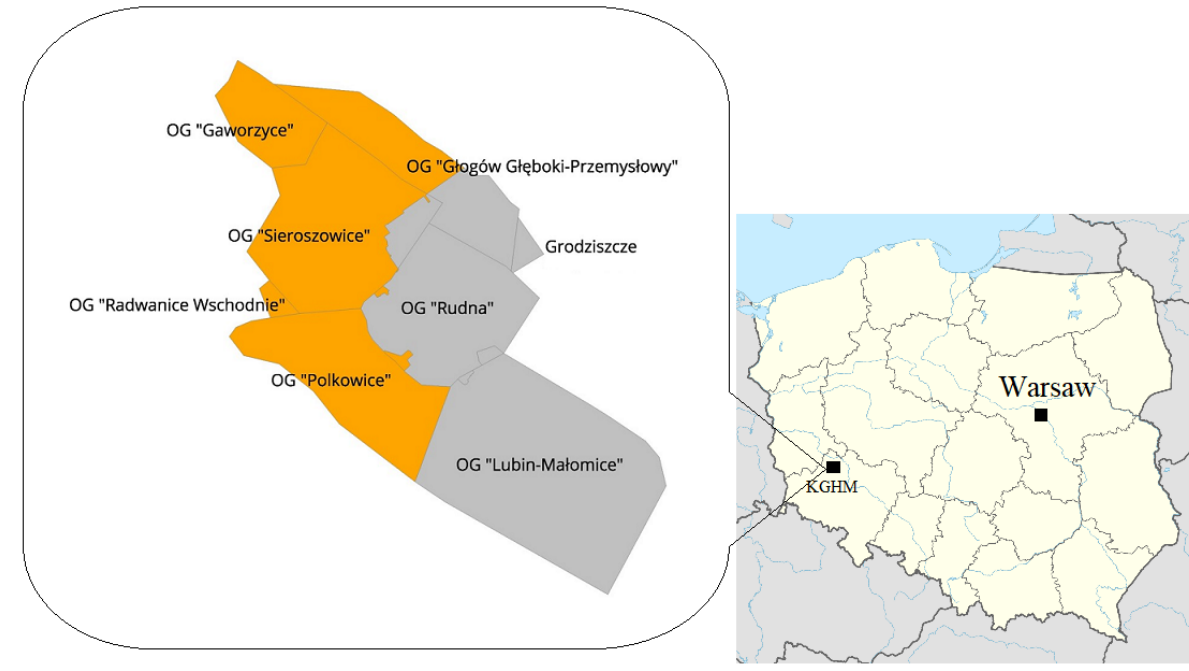
Figure 2: Location of the Polkowice-Sieroszowice copper mine.